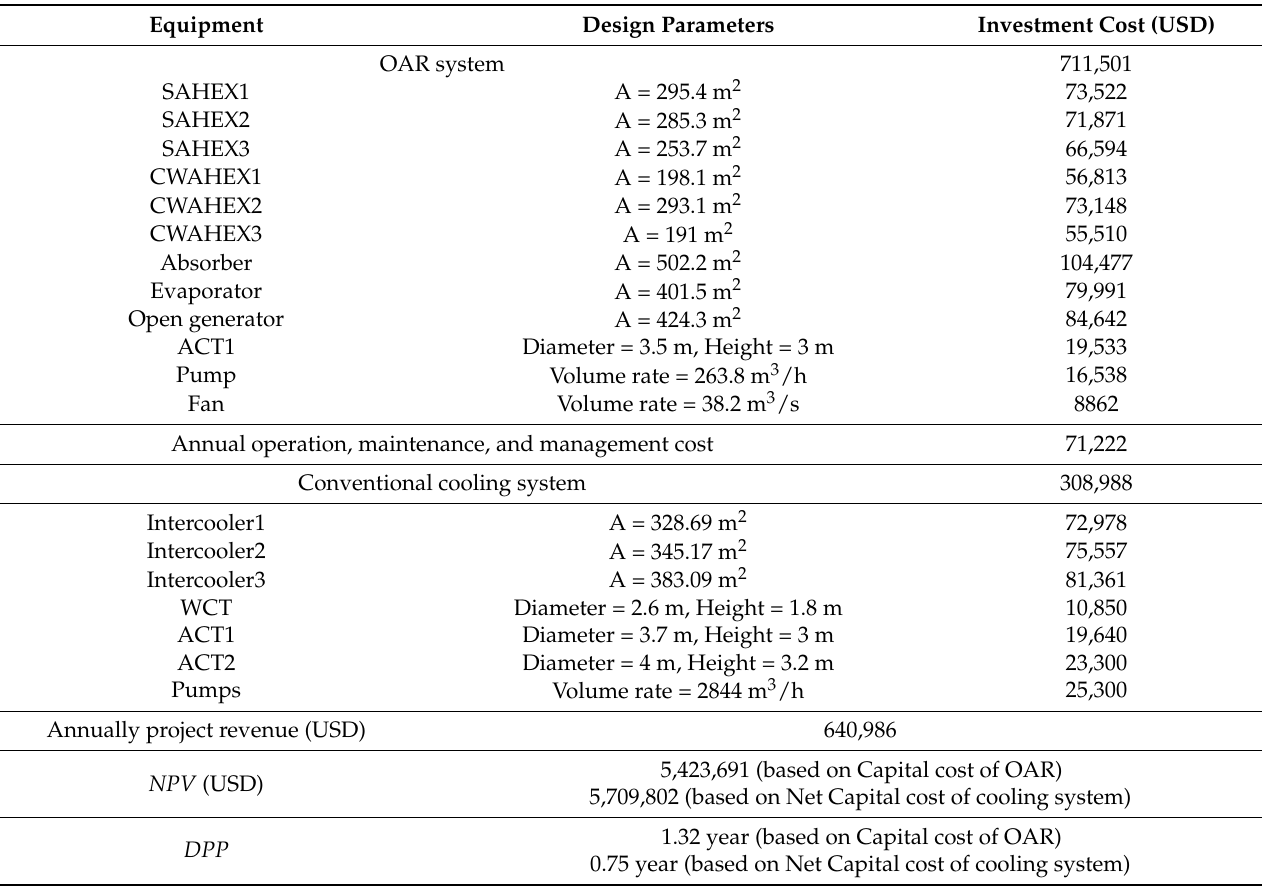
Figure 11. Influences of feed air temperature and humidity ratio on ESR and COP . Table 7. Results of economic analysis.